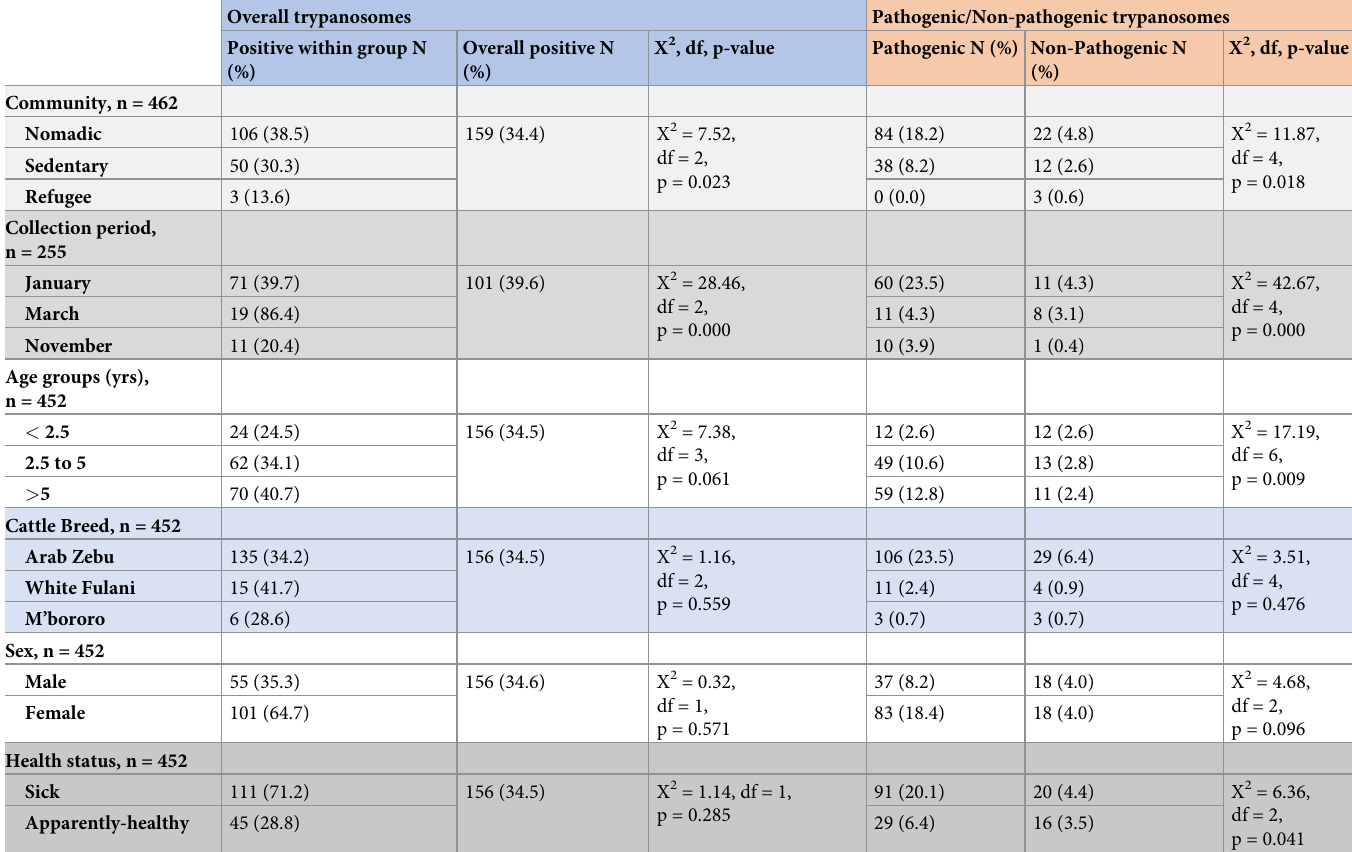
Table 1. Effect of transhumance activities, collection periods, age, breeds, and sex on trypanosomes frequency in Maro. Overall